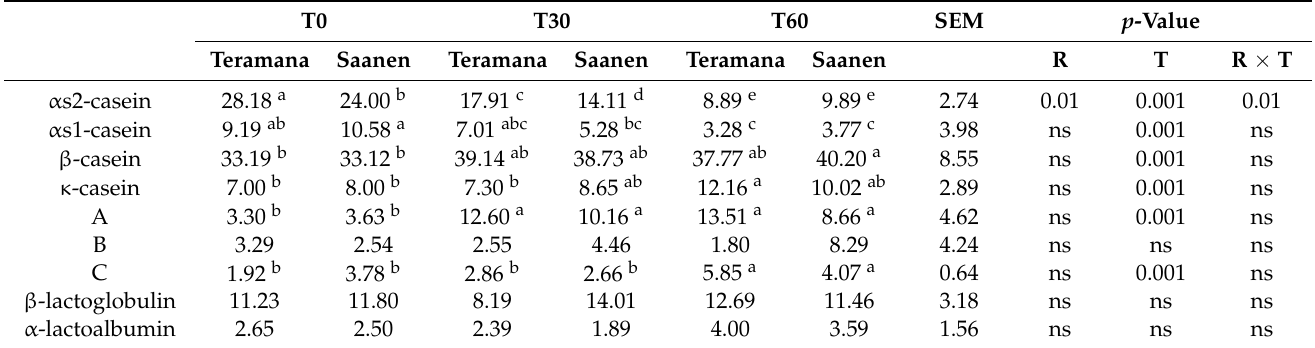
Figure 2. A representative image of SDS-PAGE analysis of cheeses at 0 (T0), 30 (T30) and 60 (T60) days of ripening, obtained from the milk of Teramana and Saanen goats. ( n = 3). Table 3. Densitometric analysis of SDS-PAGE protein bands (Figure 1) of cheese at 0 (T0), 30 (T30), and 60 (T60) days of ripening, obtained from the milk of goat breeds: Teramana and Saanen. T0 T30 T60